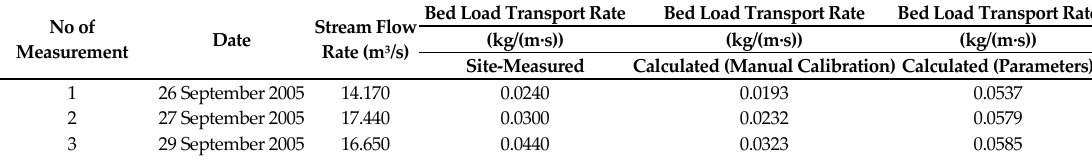
Table Α 1. Stream flow rate and bed load transport rate measurements of Nestos River—Calculated bed load transport